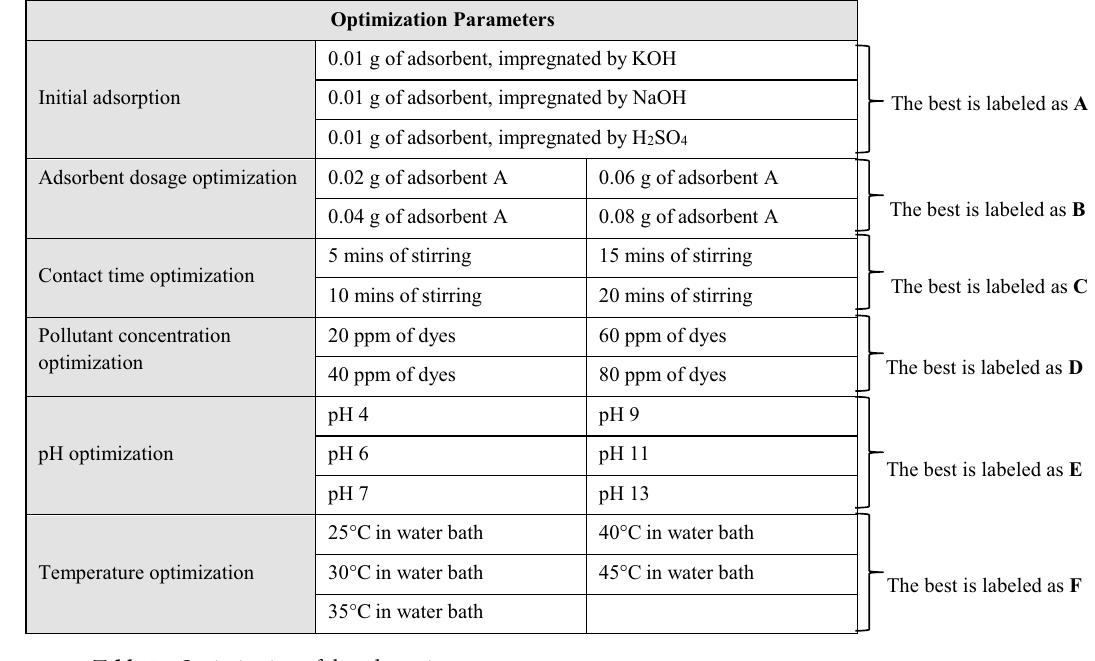
Table 5. Optimization of the adsorption